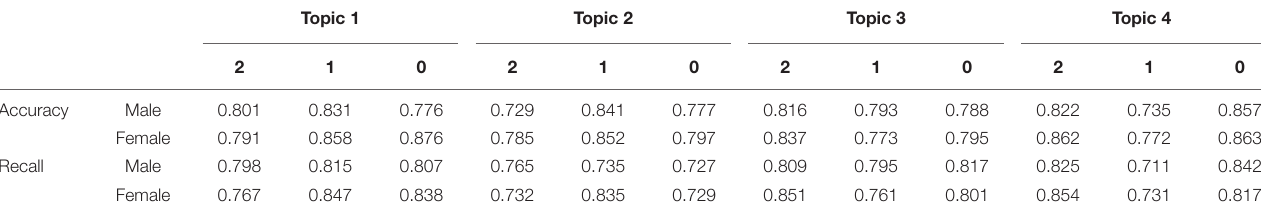
TABLE 5 | Results of the classifier for male and female users. Topic 1 Topic 2 Topic